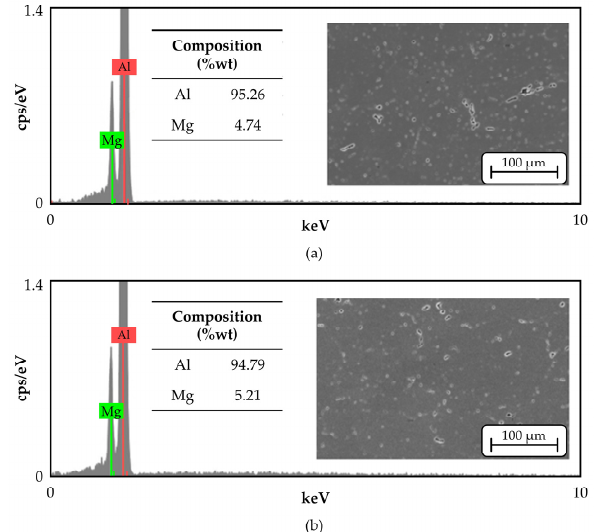
Figure 7. Chemical composition obtained by energy dispersive spectrometry (EDS) from deposited ER5356 aluminum metallographic samples cut from ( a ) wall set #1 and ( b ) wall set #2.